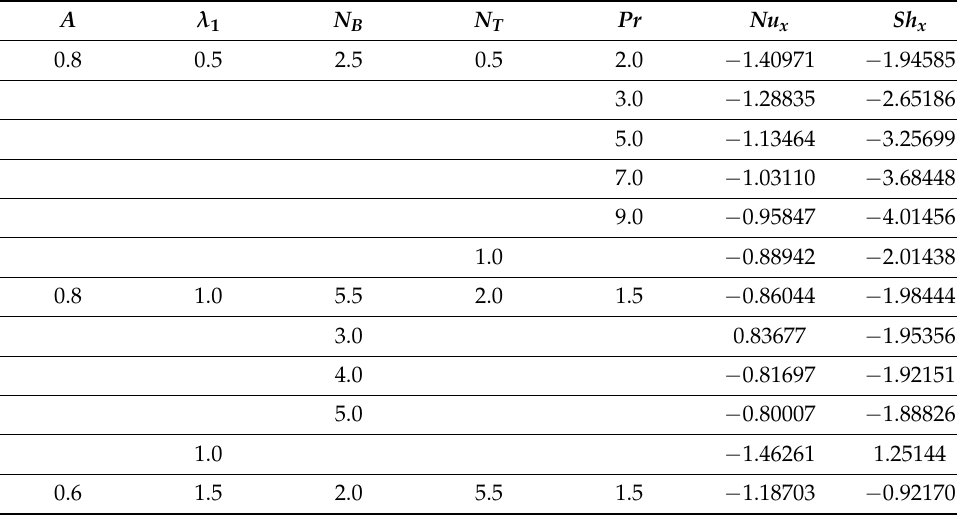
Table 2. Variation in Sh and Nu for different